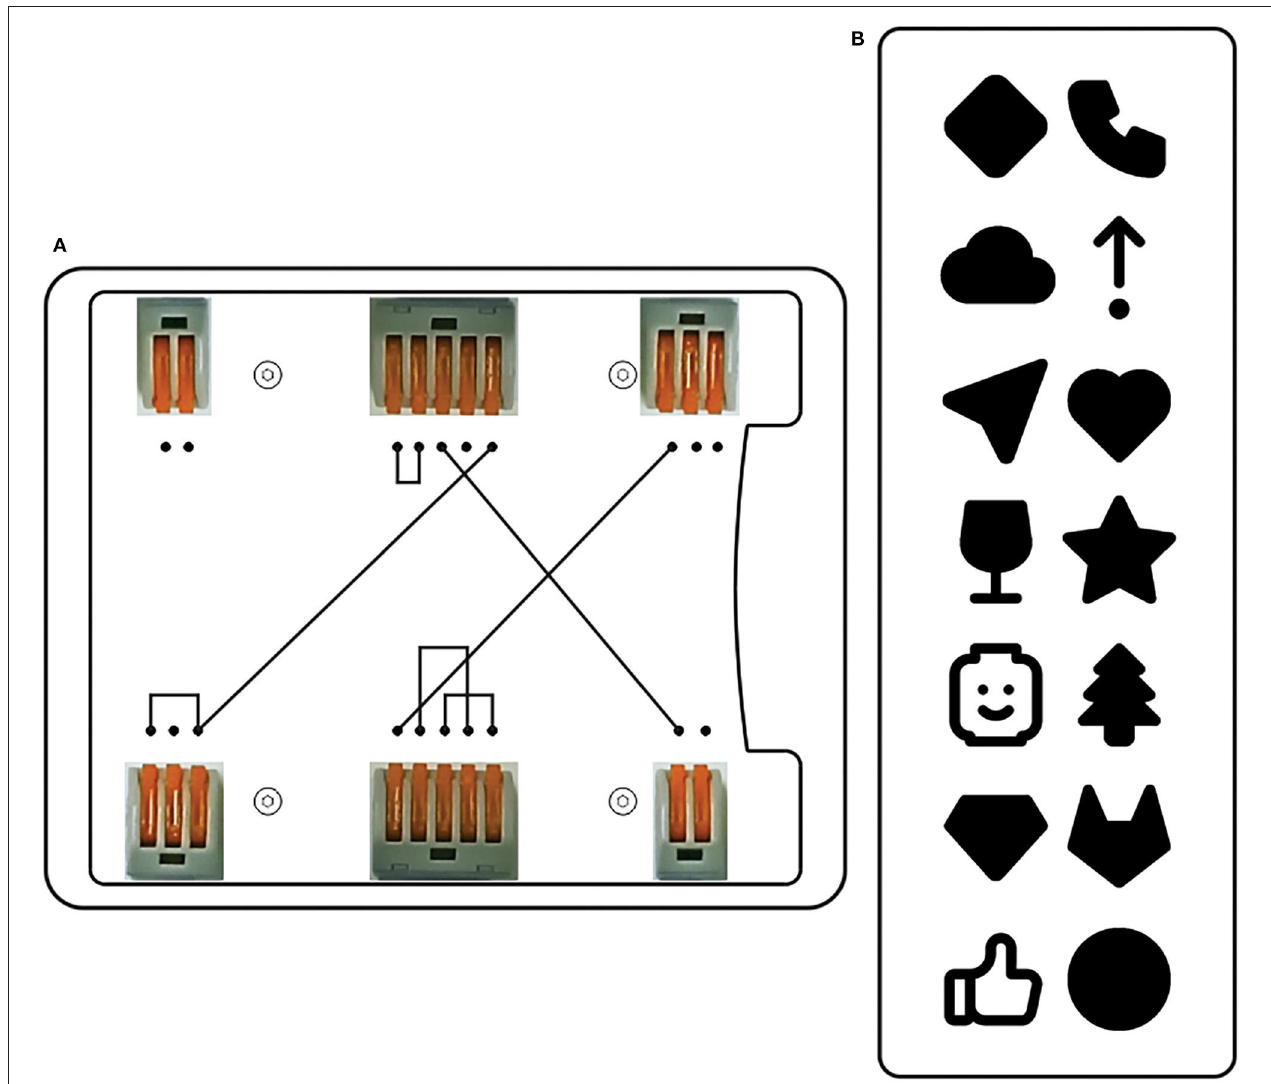
FIGURE 7 | Types of schemes (A) easy to connect, (B) harder to